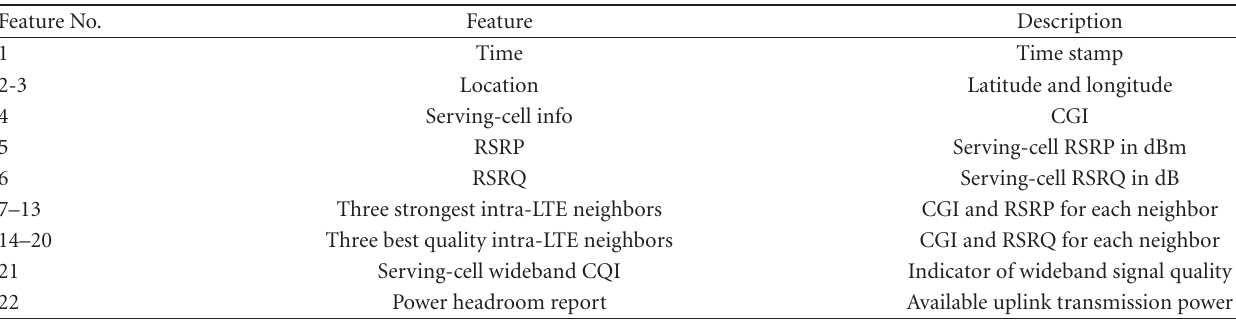
Table 1: Structure of the MDT